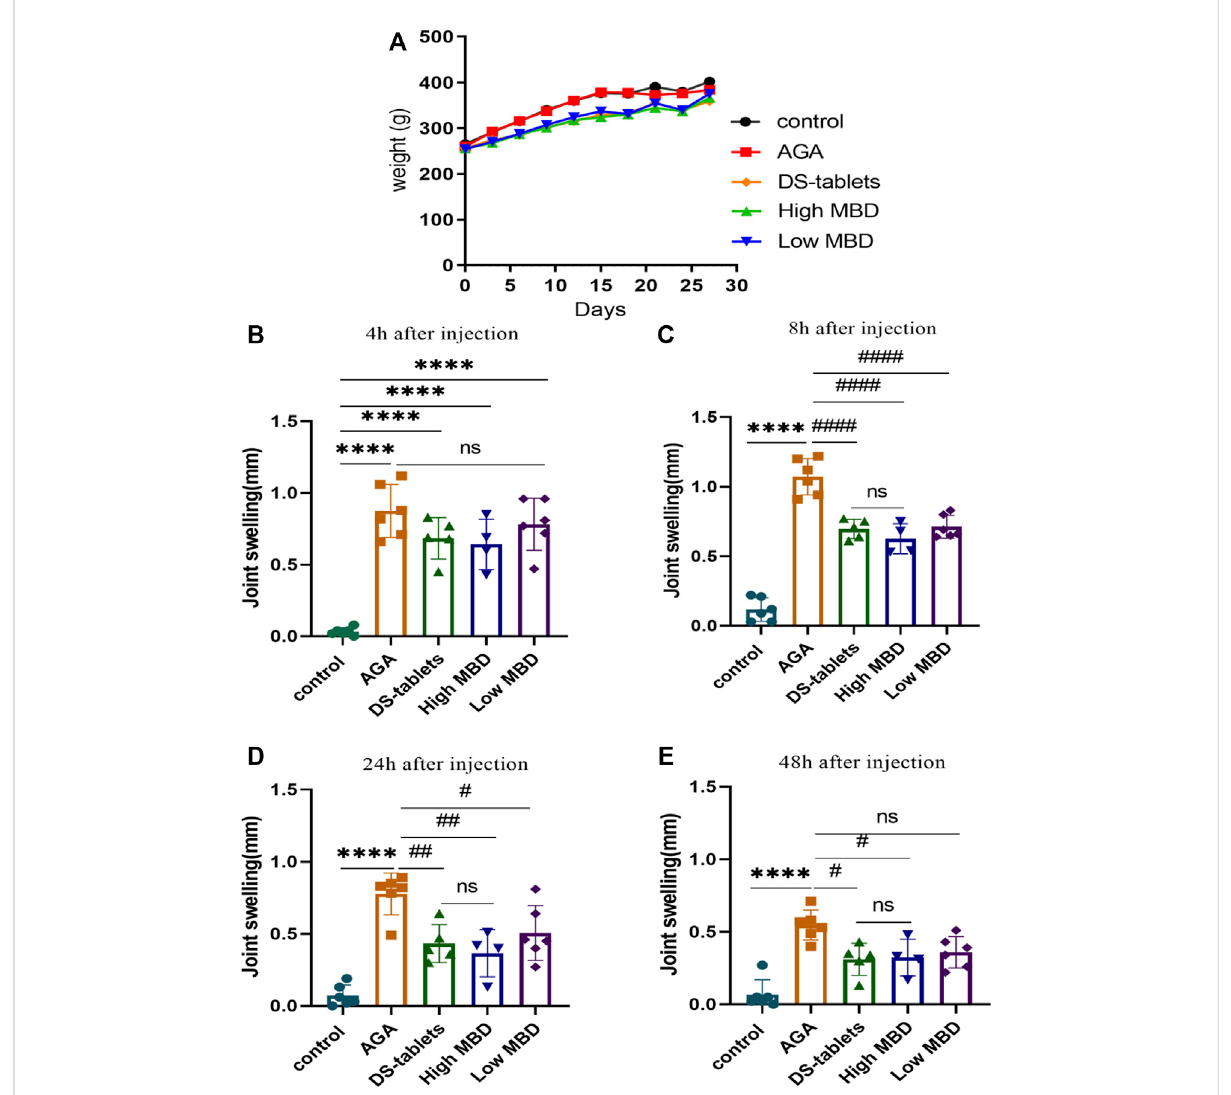
FIGURE 2 Effect of MBD on body weight and ankle swelling in AGA rats. (A) Changes in body weight. (B) Change in ankle swelling 4 h after injection. (C) Change in ankle swelling 8 h after injection. (D) Change in ankle swelling 24 h after injection. (E) Change in ankle swelling 48 h after injection . *p < 0.05, **p < 0.01, *** p < 0.001 indicated that the difference was statistically signi fi cant compared with the control group; #p < 0.05, ## p < 0.01, # ## # p < 0.001 compared with the AGA group, the difference was statistically signi fi cant. N =